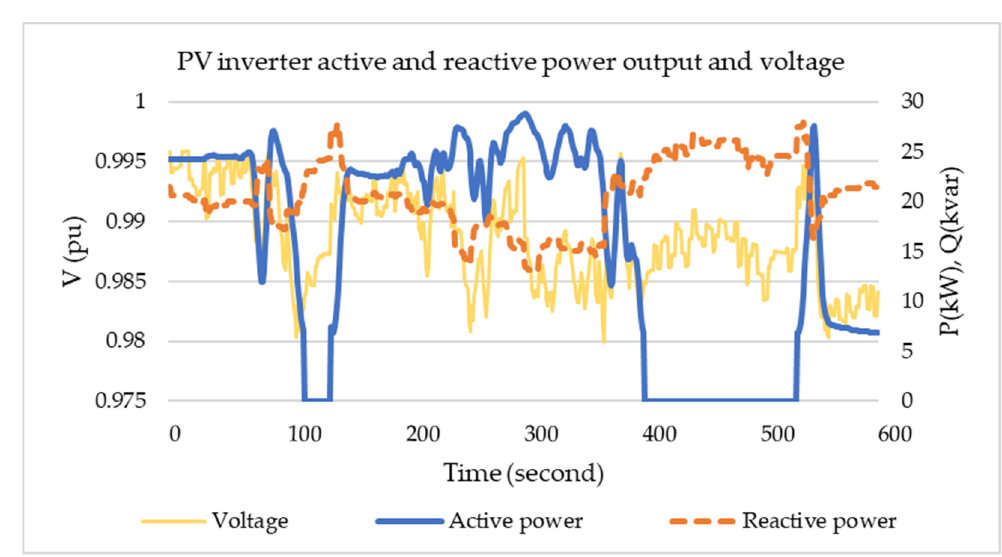
Figure 2. Voltage, and active and reactive power, of the PV smart inverter with volt–var control.